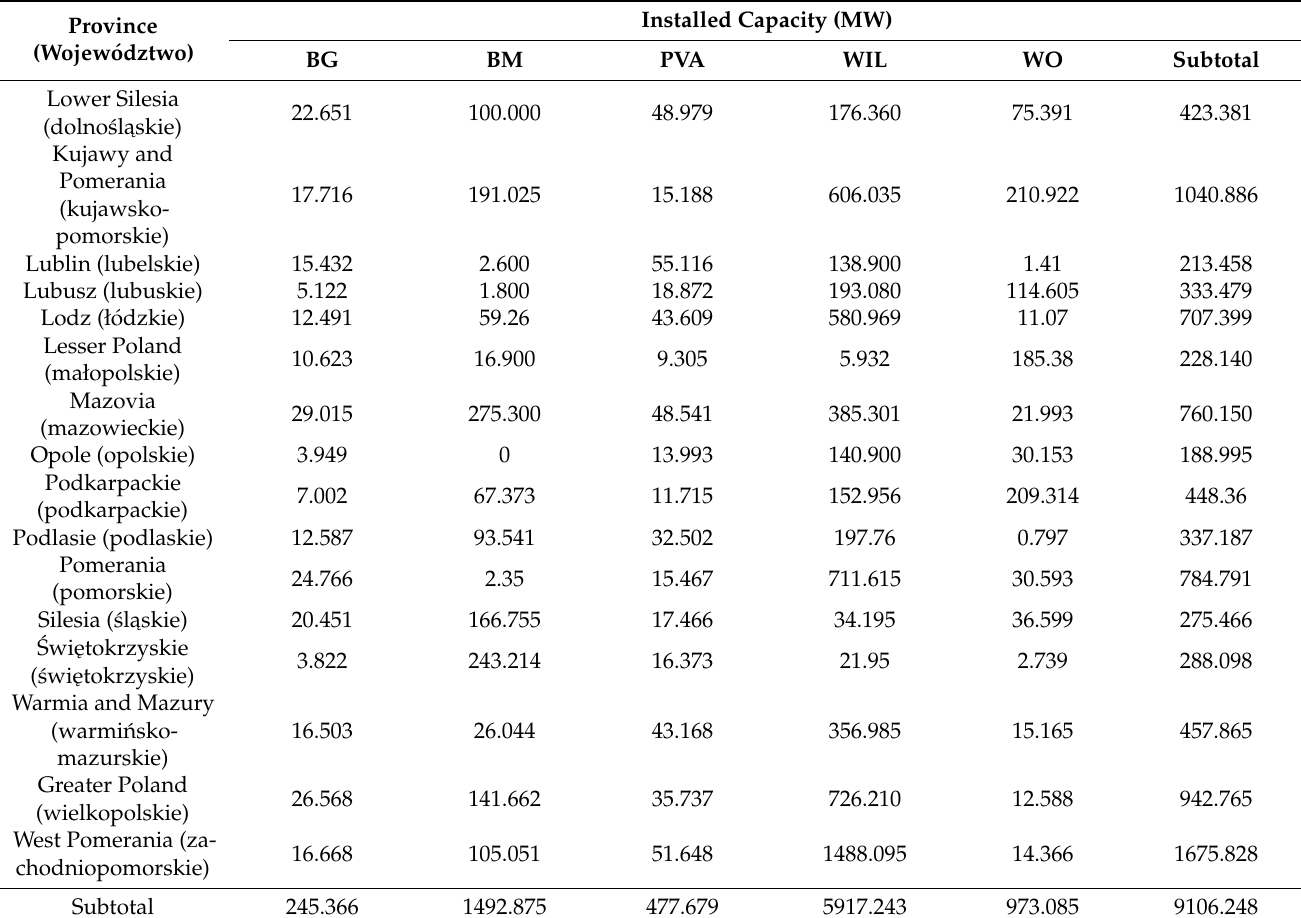
Table 6. Renewable energy installations in Poland as of 31 December 2019 (letter code in accordance with Table 7). Province